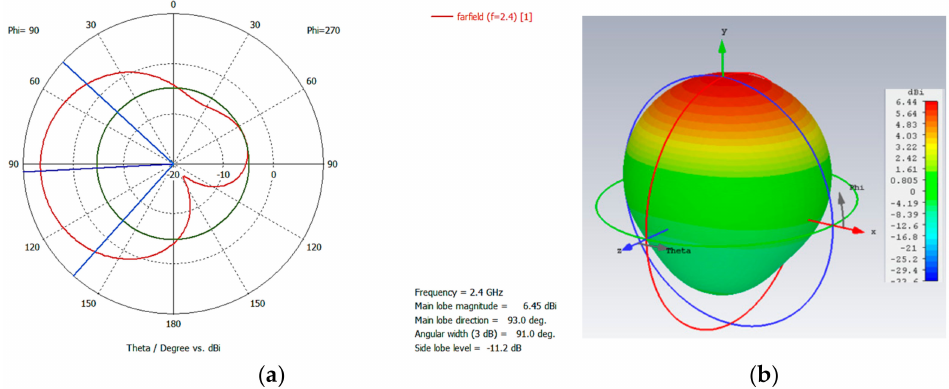
Figure4. ( a )2Dradiationdiagramand( b )3DradiationdiagramfortheWT14350 µ